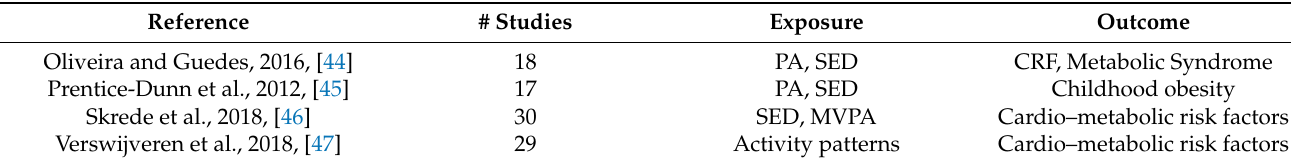
Table 3. Characteristics of the included reviews including studies on effects of SED and